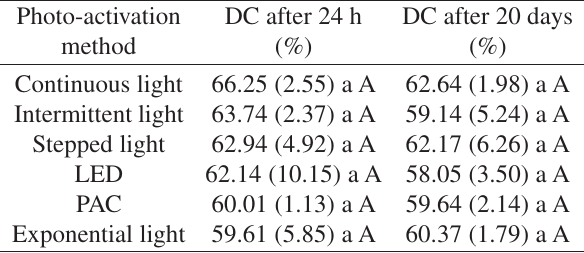
Table 2. Means of DC according to analyzed periods and photo- activation methods, for the KBr pellet technique.